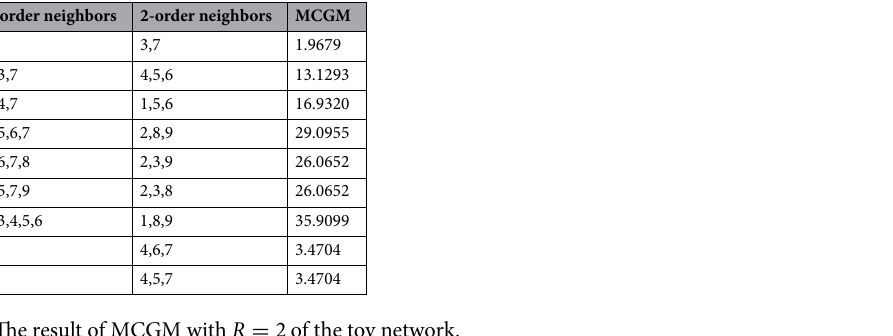
Table 2. The result of MCGM with R = 2 of the toy network.